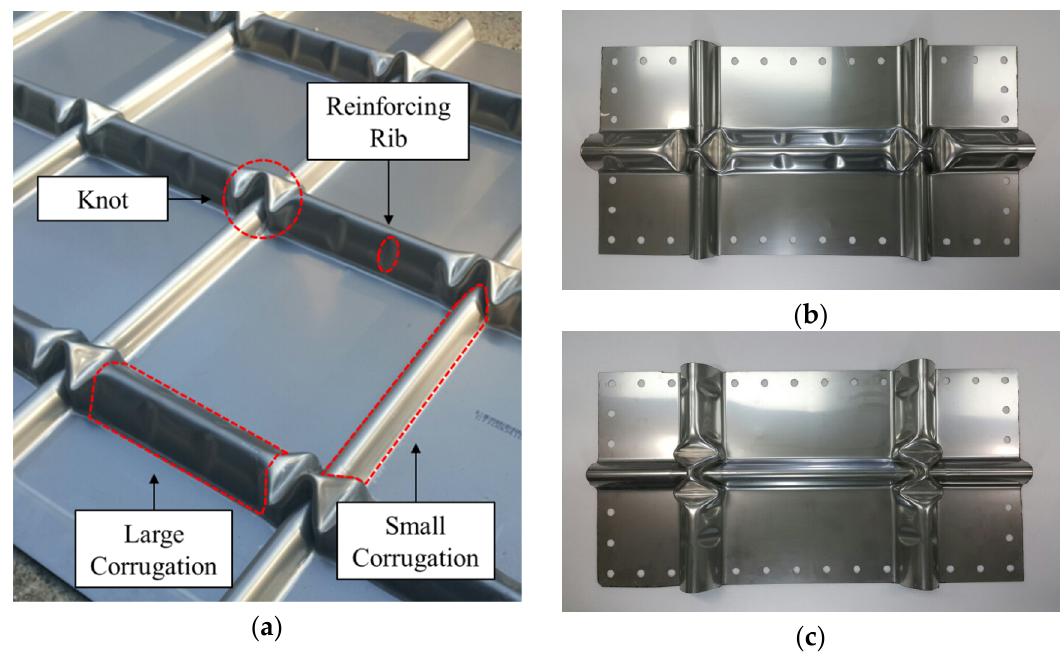
Figure 2. Specimen preparation for ( a ) membrane panel, ( b ) large corrugation, and ( c ) small corrugation.